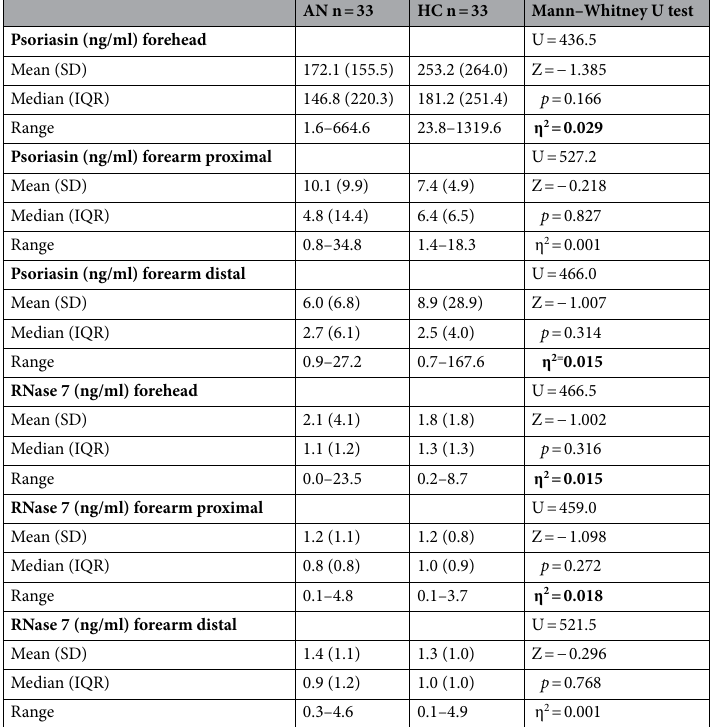
Table 2. Comparison of patients with anorexia nervosa (AN) and age- and sex-matched healthy controls (HC). η 2 eta squared, bold print indicates a small effect size. AN anorexia nervosa, SD standard deviation, IQR interquartile